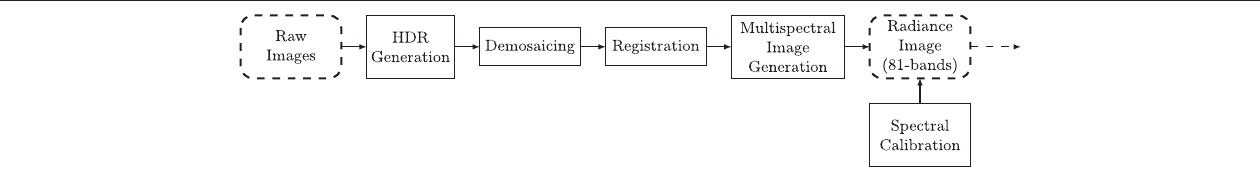
FIGURE1| Dataacquisitionpipeline.RawimagesarecapturedusingaCPFAcamerawithfourpolarizationangles,infrontofspectralbandpass fi ltersasdescribed in Section2.1 .Pre-processingsteps(HDR,demosaicing,andregistration)aredescribedin Section2.1 ,whereasspectralimagereconstructionisdescribedin Section 2.2 . The dotted arrow corresponds to the connection toward Figure 3